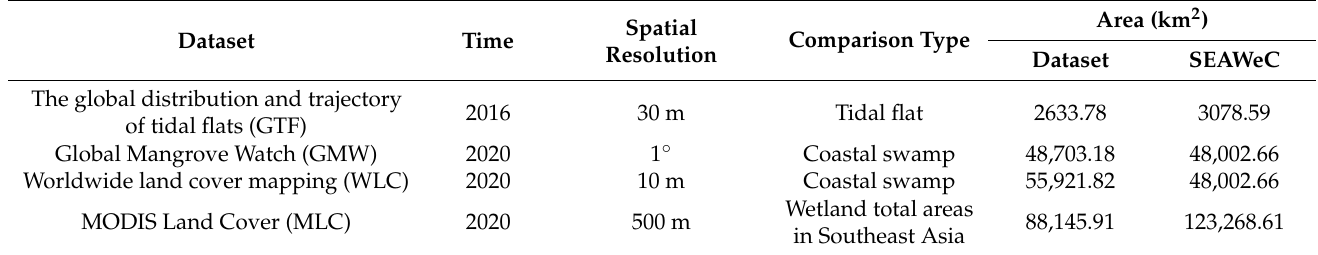
Table 6. The wetland areas of Southeast Asia from the SEAWeC, GTF, GMW, WLC, and MLC